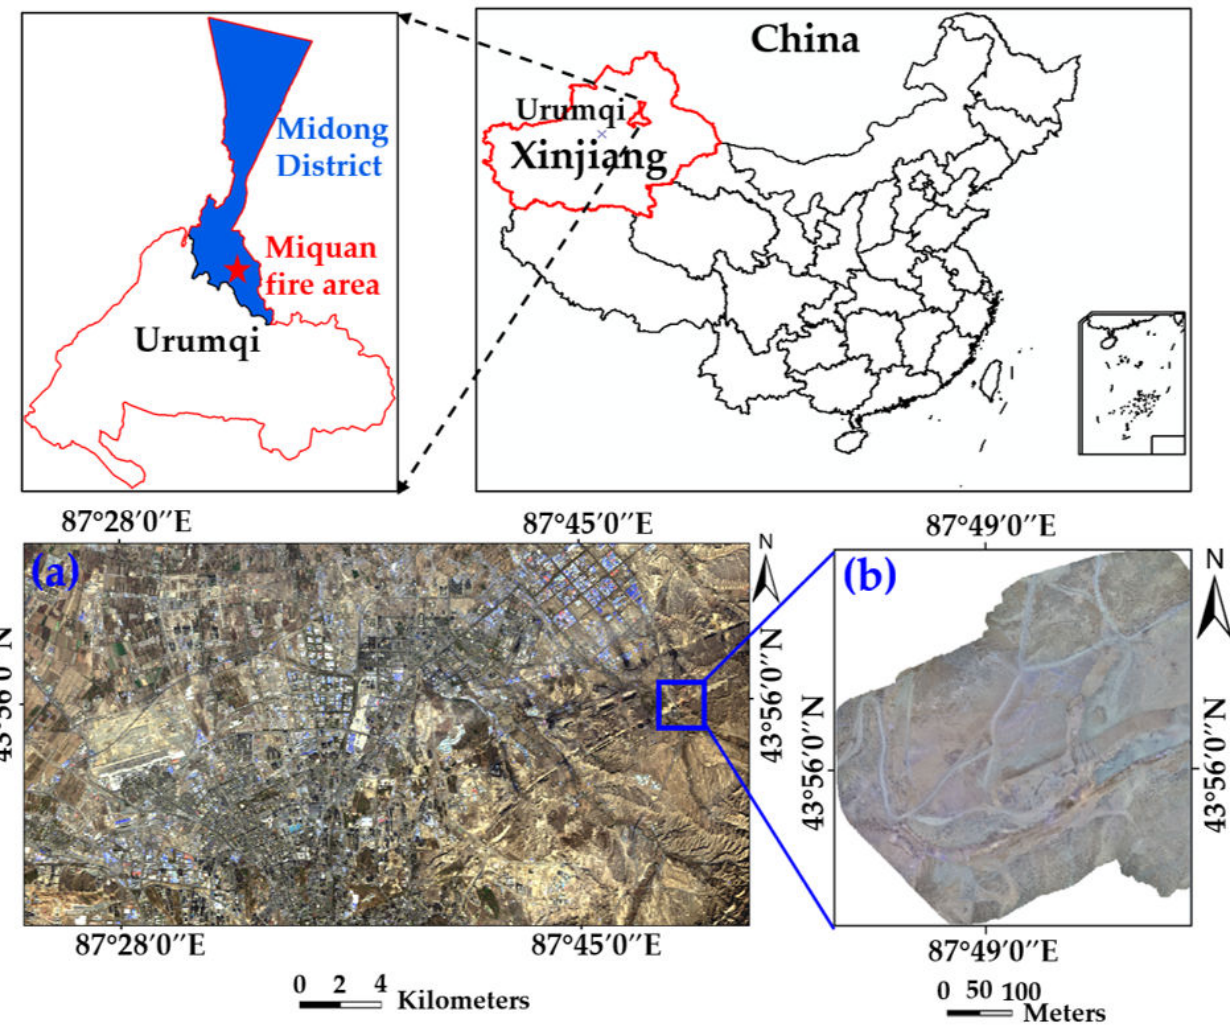
Figure 1. Location of the study area: ( a ) Landsat-8 image range and ( b ) UAV